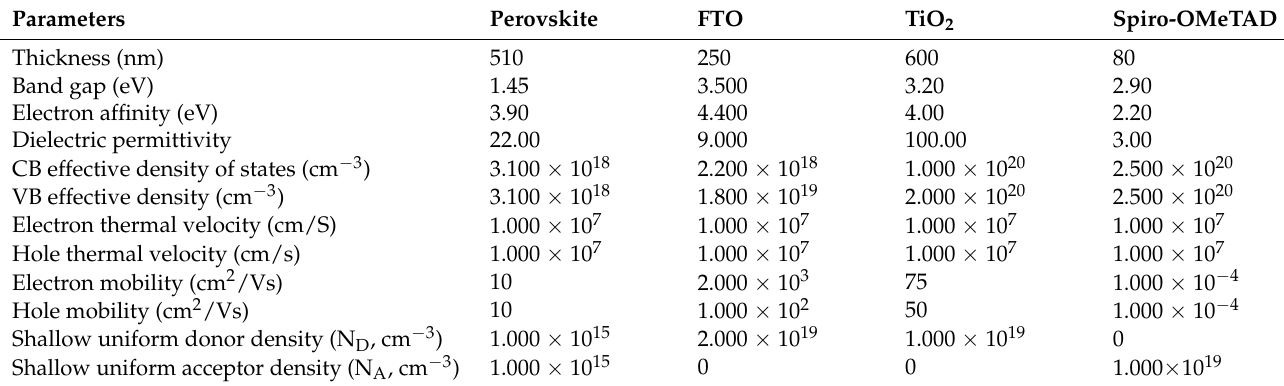
Table 1. Physical parameters of different layers used for the simulation.